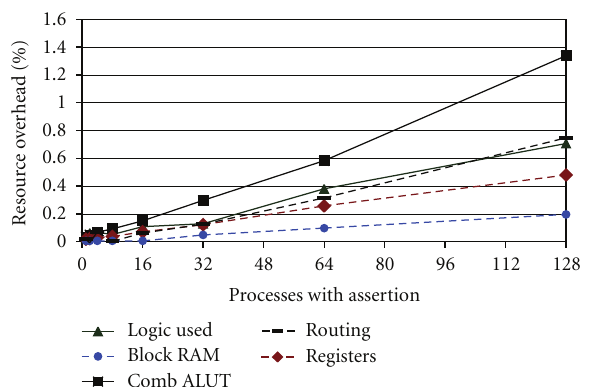
Figure 11: Optimized assertion resource scalability.